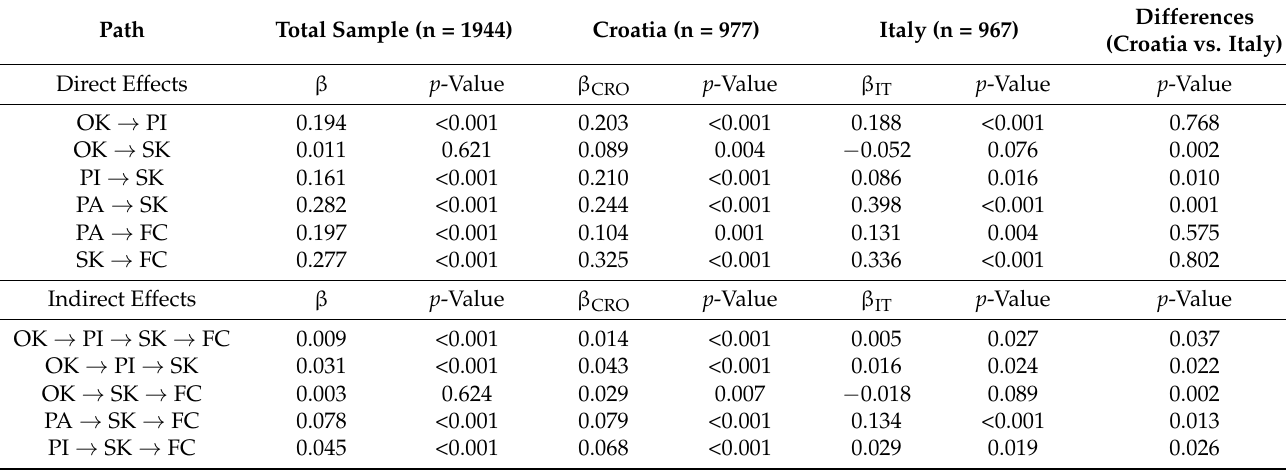
Table 5. Path coefficients of direct and indirect